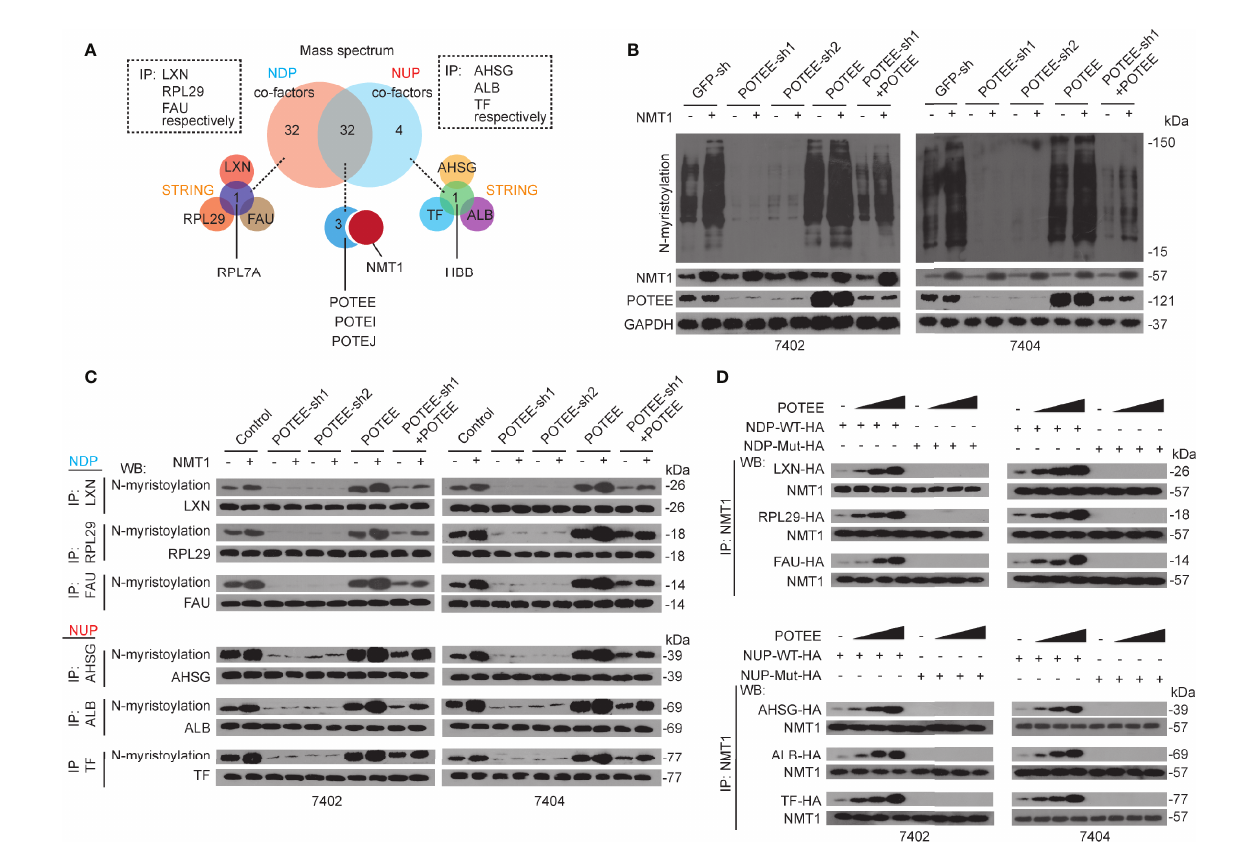
FIGURE 4 | POTEE was essential for NMT1-mediated N-myristoylation. (A) RPL7A, HBB and POTE family were identi fi ed speci fi cally and commonly interacted with NDP and NUP. Three NDP (including LXN, RPL29 and FAU) and three NUP (including AHSG, TF and ALB) were immuno-precipitated by their corresponding antibodies, respectively. The immuno-precipitates were then subjected into MS and the data (two biological replicates) were further evaluated by software STRING. (B) NMT1 stimulated global N-myristoylation depended on POTEE. Global N-myristoylation were measured by CuAAC in control cells, Bel-7402 and Bel-7404 cells with or without POTEE knocked down or overexpressed, as indicated. (C) POTEE was essential for N-myristoylation of both NDP and NUP. N-myristoylation of NDP and NUP was measured by CuAAC and WB in the immuno-precipitates that were immuno-precipitated by the corresponding antibodies, as indicated, in Bel-7402 and Bel-7404 cells. (D) POTEE was critical for the interaction between NMT1 and NDP/NUP. Endogenous NMT1 was immuno-precipitated by anti-NMT1 antibodies in Bel- 7402 and Bel-7404 cells overexpressing exogenous WT (with functional NDP/NUP motif) or Mutant (without functional NDP/NUP motif) NDP/NUP-HA. The cells were also transfected with or without increasing concentration of POTEE expressing plasmids. Images of WB are representative ones of 3 independent